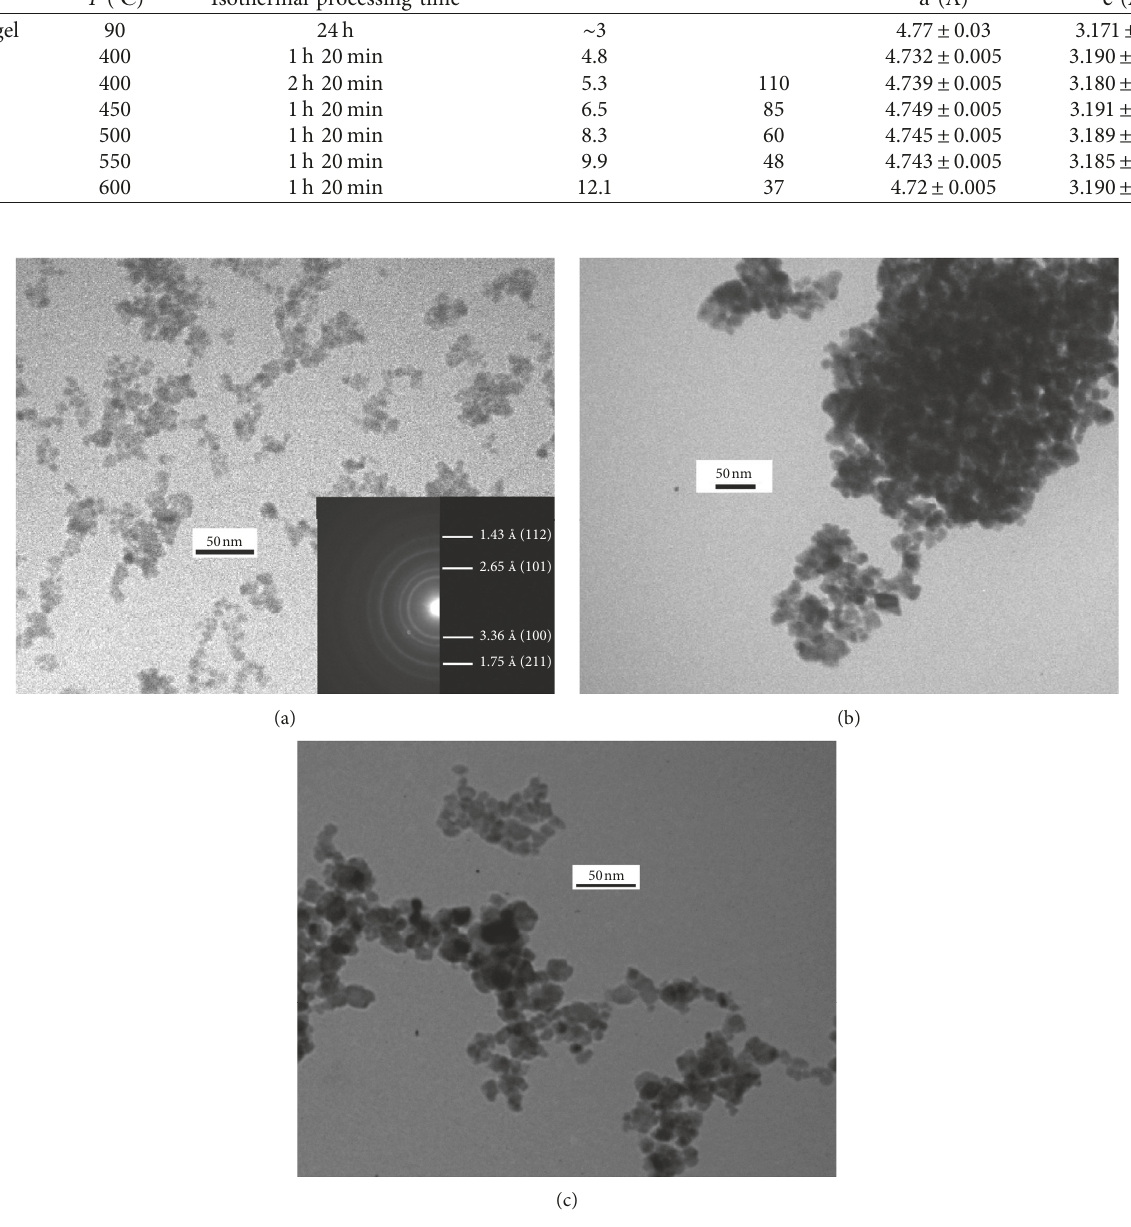
Figure 3: TEM image of the (a) material obtained through calcination of the xerogel at 400 ° C during 2 hour 20 minutes (electron diffraction with d-spacing and corresponding hkl indices for SnO 2 (in round brackets) is presented in the inset), (b) undoped, and (c) doped with 0.24wt.% Pd gas-sensitive materials on the base of nanosized SnO 2